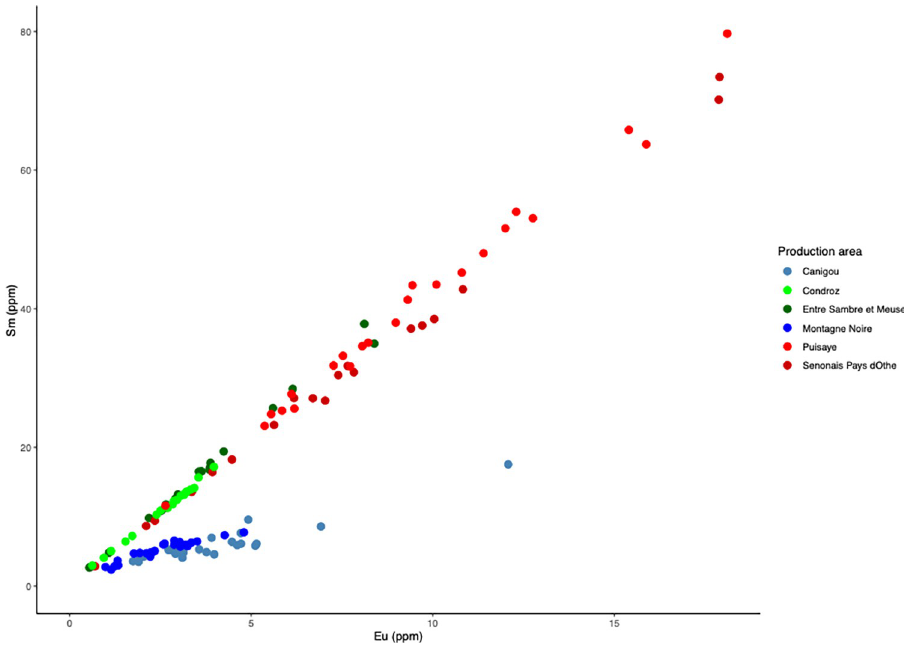
Fig 11. Eu and Sm content of the production area